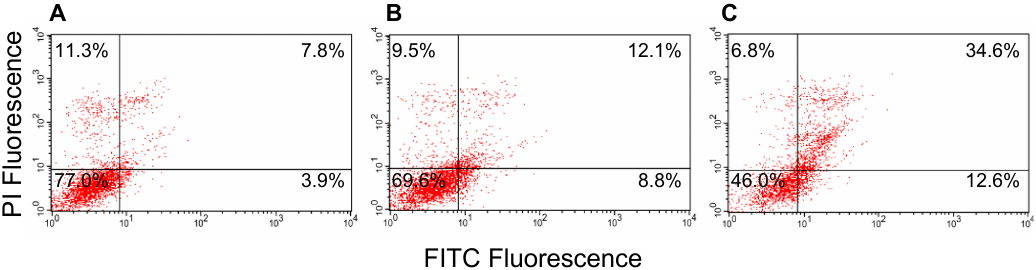
Figure 8. Apoptosis analysis with annexin V-FITC / PI double staining on MCF-7 cells treated for 96 h with ( A ) control, and AS1411 at ( B ) 1 µ M and ( C ) 10 µ M. For all panels: upper left quadrants, necrotic cells; upper right, advanced apoptotic cells; lower left, viable cells; lower right, early apoptotic cells. These results are representative of three independent experiments.